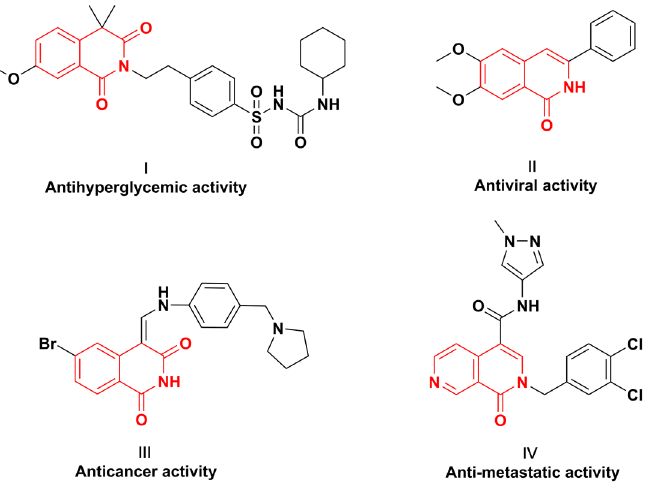
Figure 1. Selected biologically active compounds containing the isoquinolinone structural motif.